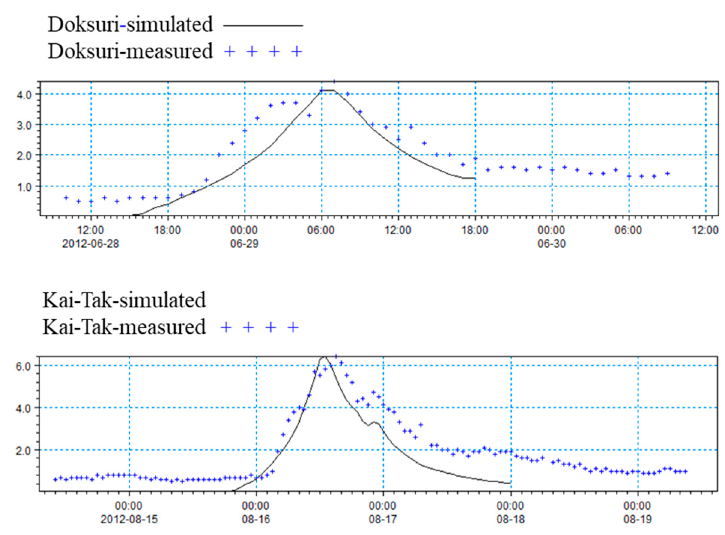
Figure 7. Typhoon (Doksuri and Kai-Tak) verification results.